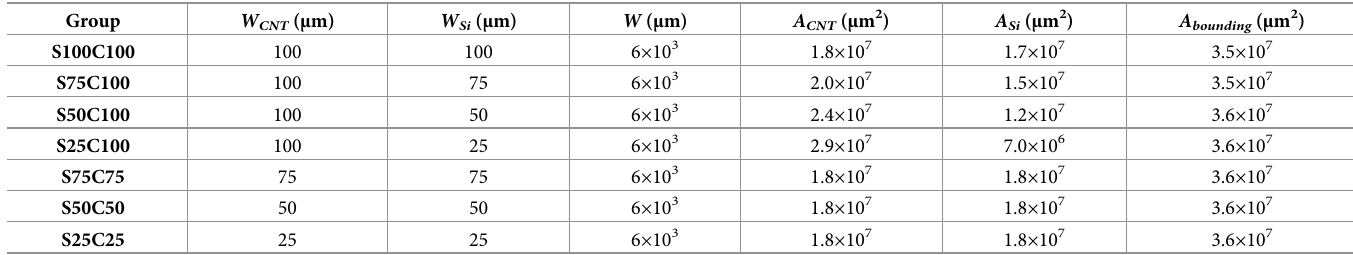
Table 1. Geometric measurements for the Euclidean electrodes. Group